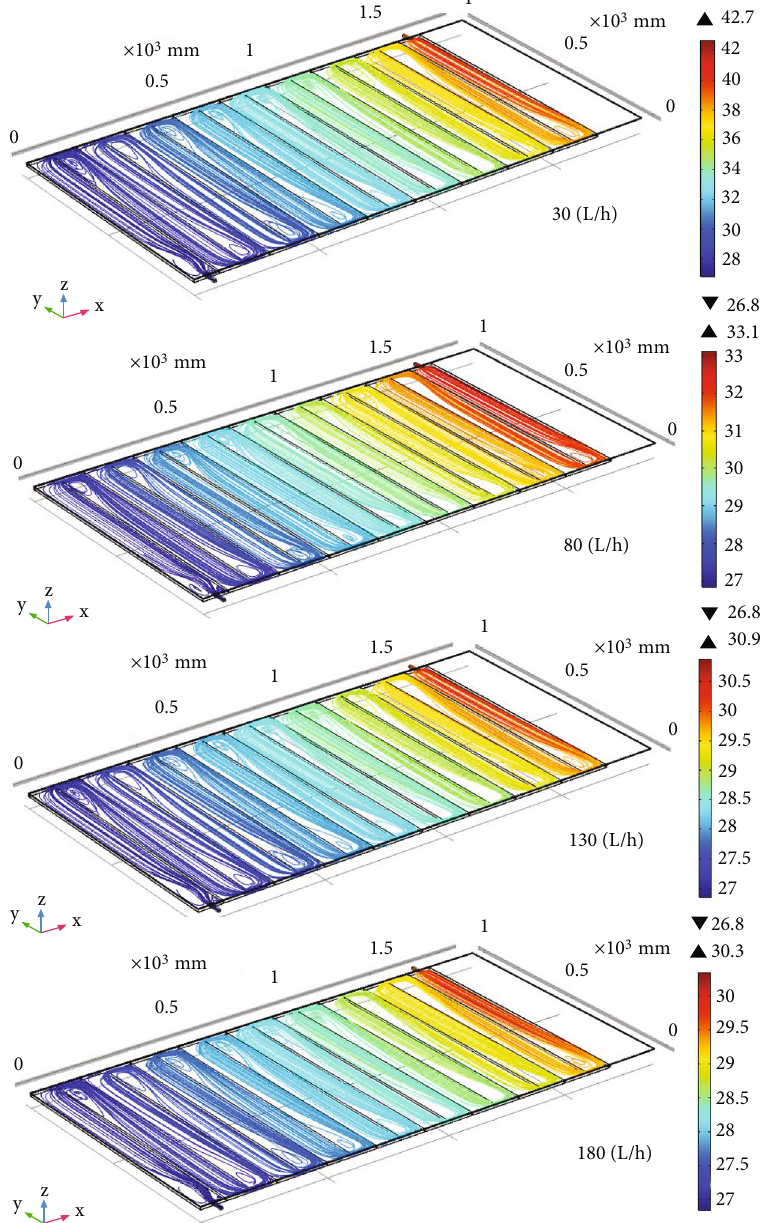
Figure 7: Outcome of mass fl ow rate on PVT streamlines plot with G = 500W/m 2 , T